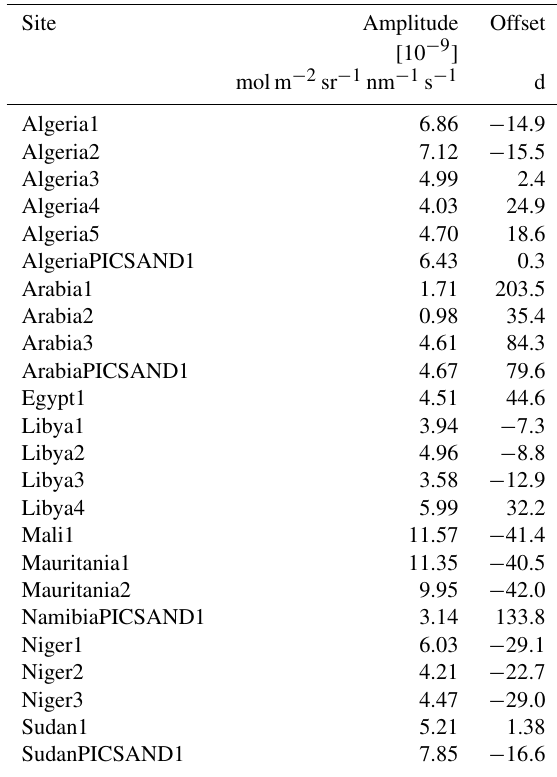
Table 5. Amplitude and period offset of fitted and subtracted sine